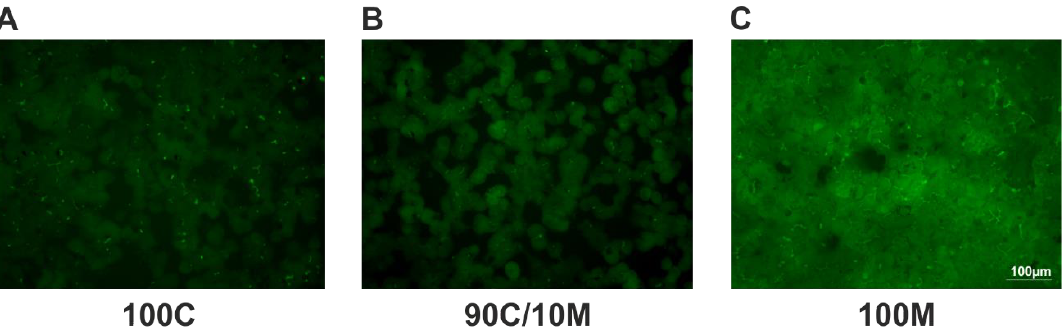
Figure 6: Formation of bile canaliculi in primary human hepatocyte (PHH) sandwich cultures (SCs) between different extracellular matrices (ECMs). PHHs were cultured for 6 days between two layers of ( A ) pure collagen type I (100C), ( B ) collagen type I supplemented with 10 % Matrigel (90C/10M) or ( C ) pure Matrigel (100M). Bile canaliculi were visualized by the fluorescent CDF (5- (and 6) -carboxy-2-, 7- dichlorfluorescein) that is transported into the bile canaliculi via the apical hepatocyte membrane trans- porter MRP2 (multidrug resistance-associated protein 2). Imaging analysis was performed by three dif- ferent investigators independently. Representative fluorescence microscopy images are shown. Magni- fication: 200x. Scale Bar 100 µm. A comprehensive presentation of images from all three donors can be found in Supplementary Figure